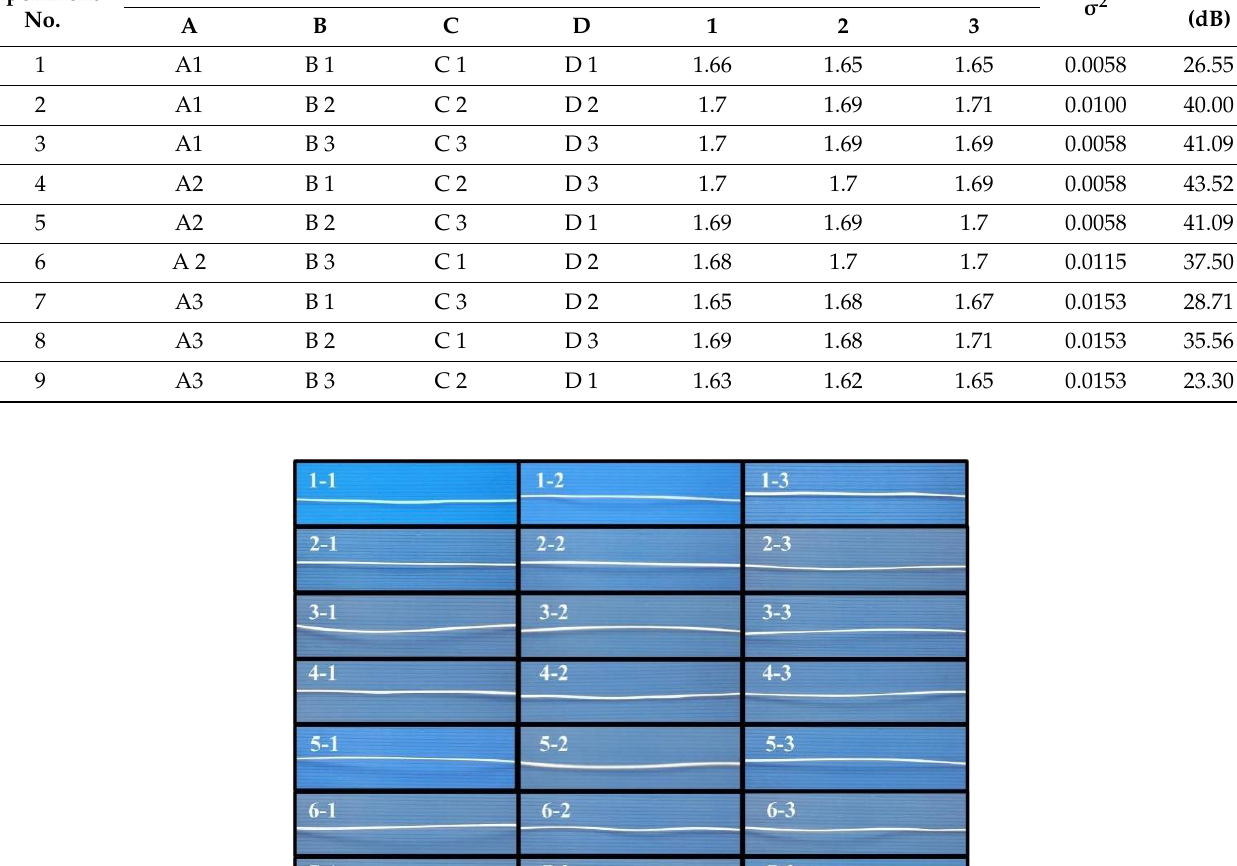
Table 2. Experimental results of average diameter of PLA filament.